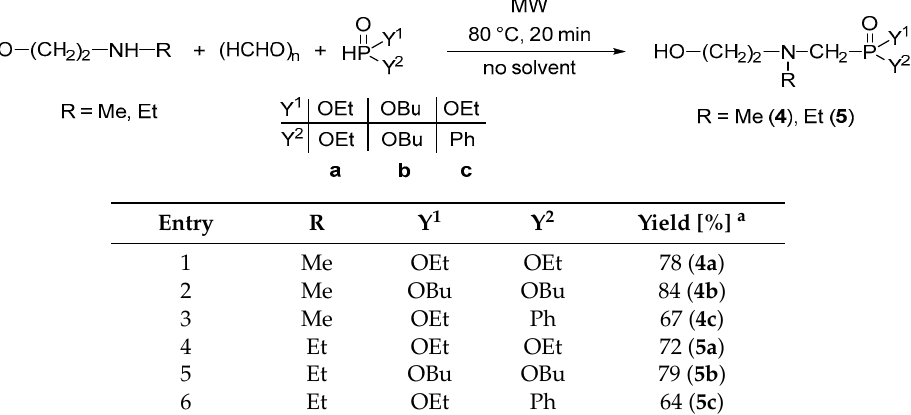
Table 2. Condensation of N -alkylethanolamines, paraformaldehyde, and dialkyl phosphites or ethyl phenyl- H -phosphinate.